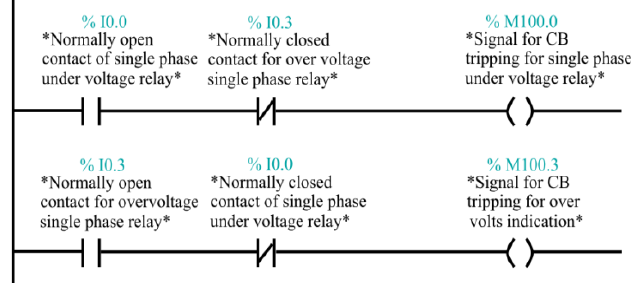
Fig. 4. Ladder diagram for single phase digital and analogue under/over voltage relay.